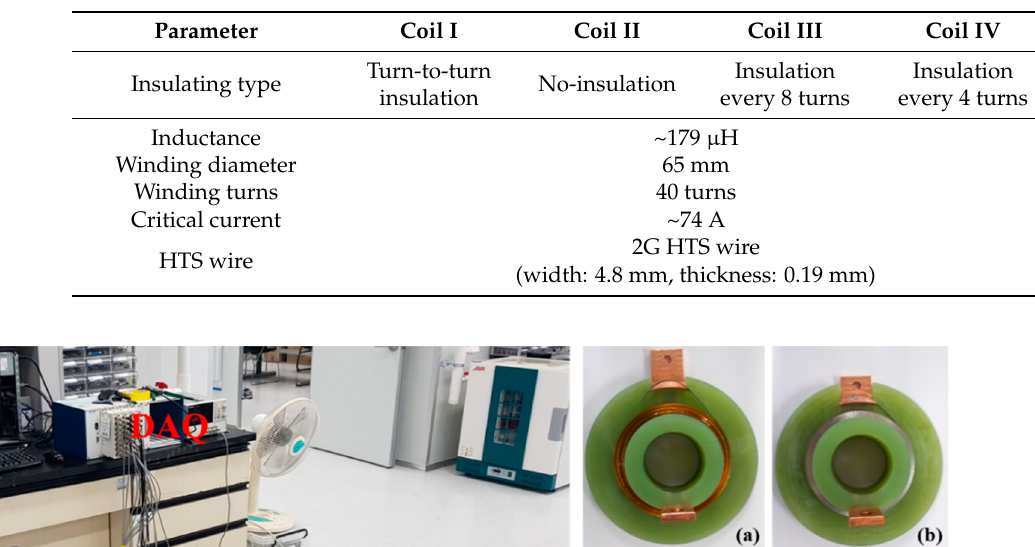
Table 1. Specifications of the HTS coils.